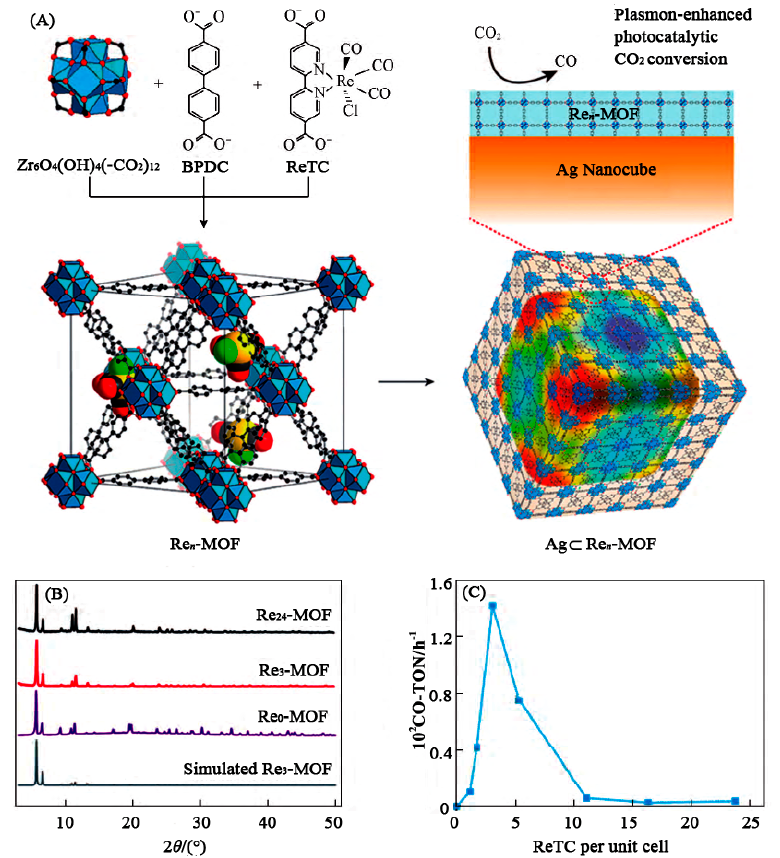
Figure 3. Structures of Ren-MOF and Ag Ren-MOF based catalysts ( A ), PXRD of Ren-MOFs ( B ), and the photocatalytic activity of Ren-MOF ( C ). Reprinted from ref. 81 with permission by the American Chemical Society.